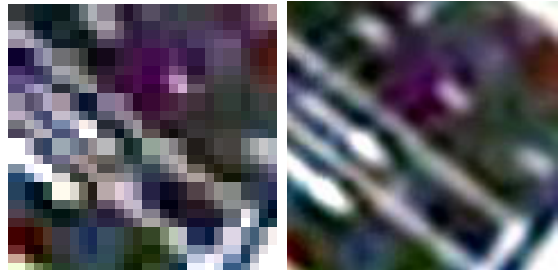
Figure 8. 30*30 LR \ 120*120 SR Road marking in the Superview-1 satellite